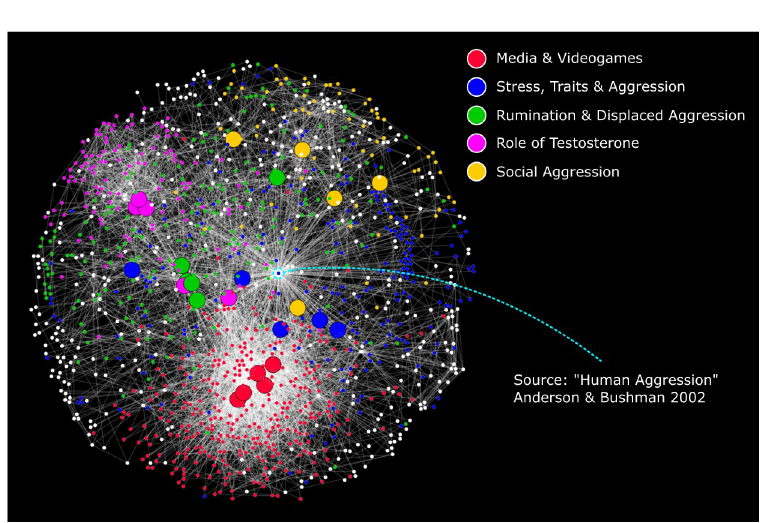
Fig 2. Top 5 communities in the human aggression network. (i) Media and Videogames (red), (ii) Stress, Traits, and aggression (blue), (iii) Rumination and Displaced aggression (green), (iv) Role of Testosterone (pink), (v) Social aggression (yellow). The largest nodes represent the five most influential papers within each community.